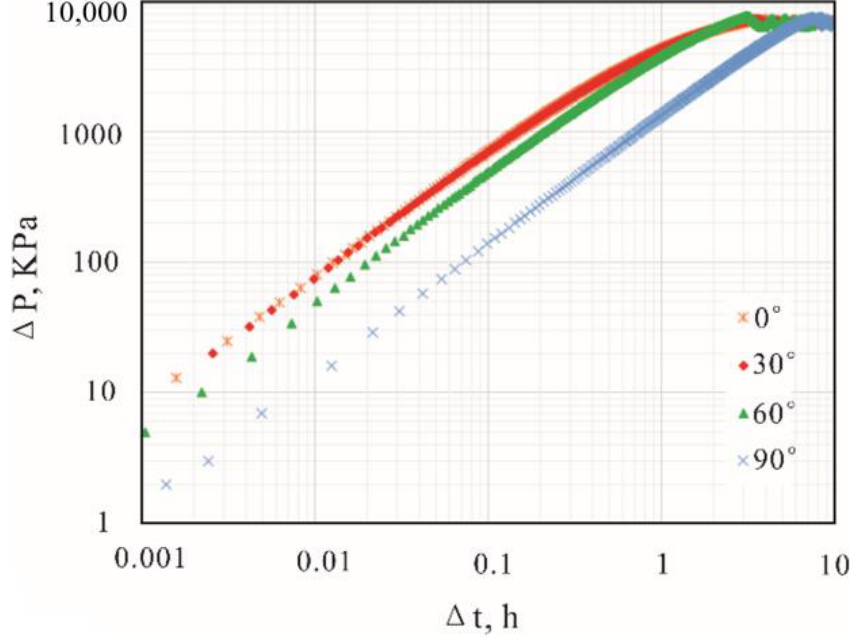
Figure 9. Log-log plots of the pressure difference in four fracture models with different dip angles.